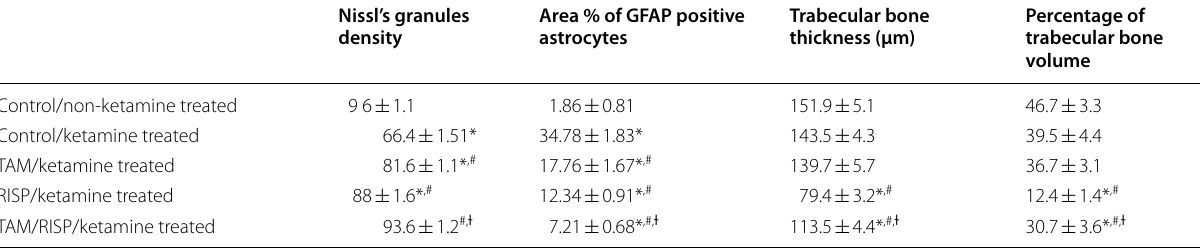
Table 3 Showing mean SD of Nissl granules density, area % of GFAP positive astrocytes, trabecular bone thickness and percentage ± of trabecular bone volume in different groups